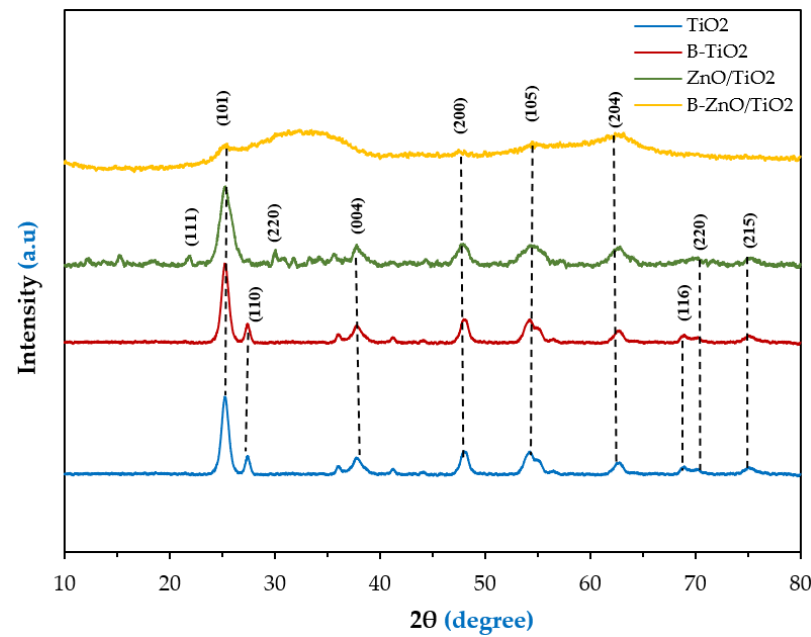
Figure 2. XRD patterns of TiO 2 , B-TiO 2 , ZnO/TiO 2 , and B-ZnO/TiO 2 . The SEM images of pure TiO 2 , B-TiO 2 , ZnO-TiO 2 , and B-ZnO/TiO 2 are presented in Figure 3.